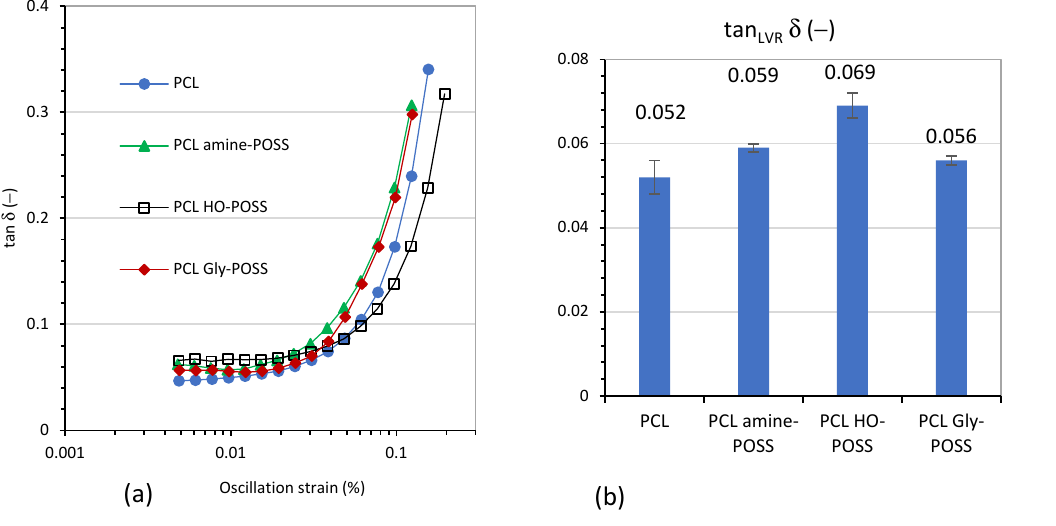
Figure 2. Loss tan δ ( − ) of PCL modified by POSS additives as a function of oscillation strain ( a ). Values of loss tan δ ( − ) measured for linear viscoelastic region (LVR) ( b ). Temperature of the measurements 25 ◦ C, angular frequency 10 rad · s − 1 .